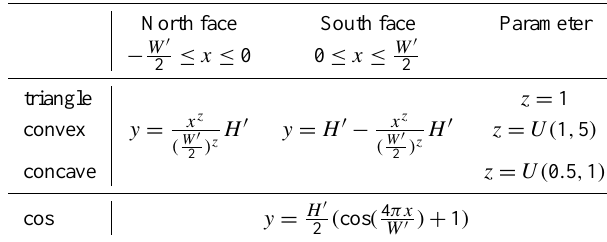
Table 3. Equations used for simulating the different penitente shape geometries based on the size parameters H 0 and W 0 (note: for the penitente trough below the sensor H = H 0 and W = W 0 ), where x is the horizontal coordinate centered around each penitente trough, y is the vertical coordinate and z is a sample of the uniform distribution U( min , max ) for the convex and concave shapes. These equations relate to the penitente shapes shown in Fig.